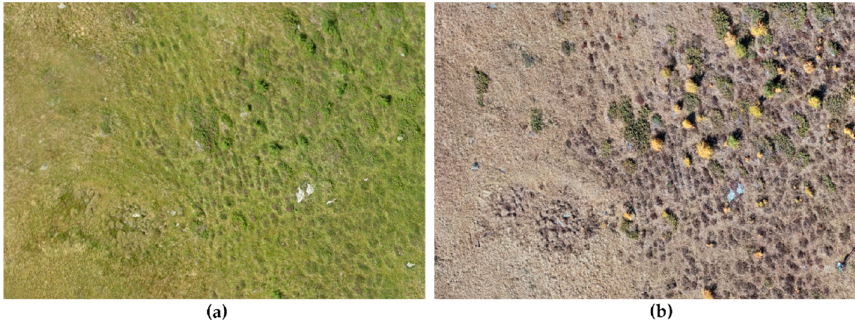
Figure 3. Same portion of the study area extracted from the images that were acquired by drone during two different phenological phases, in mid-August ( a ) and mid-October ( b ) 2018.